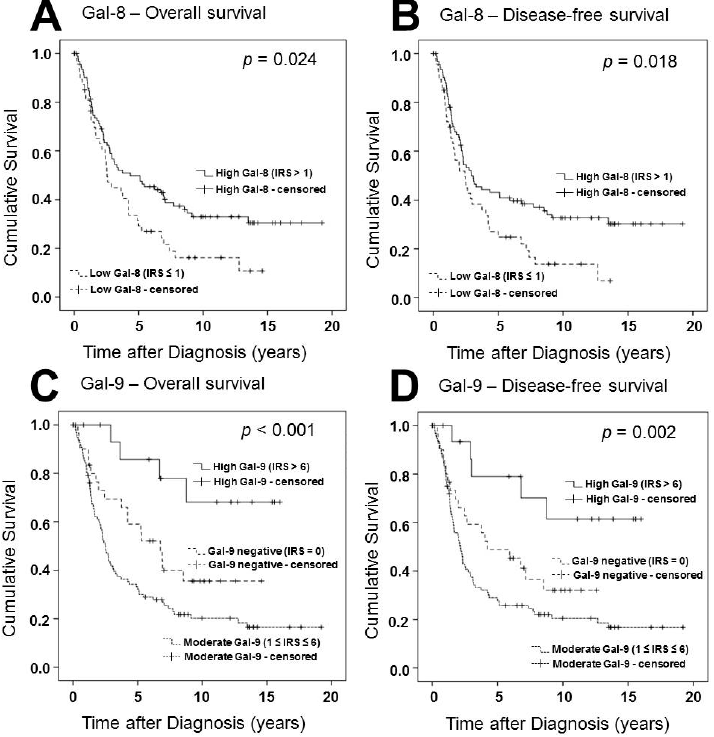
Figure 2. Survival times of patient groups with different galectin-8 and -9 expression levels were compared. Patients with high Gal-8 expression in the cytoplasm showed better progression-free ( A ) and overall survival ( B ) compared to patients without or with low Gal-8 expression. Cases with a moderate Gal-9 expression in the cytoplasm displayed a reduced progression-free ( C ) and overall survival ( D ) compared to Gal-9 negative cases. However, patients with high Gal-9 expression showed the best progression-free ( C ) and overall survival ( D ). Galectin-8 and -9 expression was determined in the cytoplasm of cancer cells using IHC and immunoreactivity (IR) scores. Survival times were plotted as Kaplan–Meier graphs. Graph shows the percentage of living patients (vertical axis) in dependence of time (horizontal axis). Patients without reported death who exited the study before the observation period ended were censored by the software. Censoring events have been marked in the graphs. Table 2. Multivariate analysis.